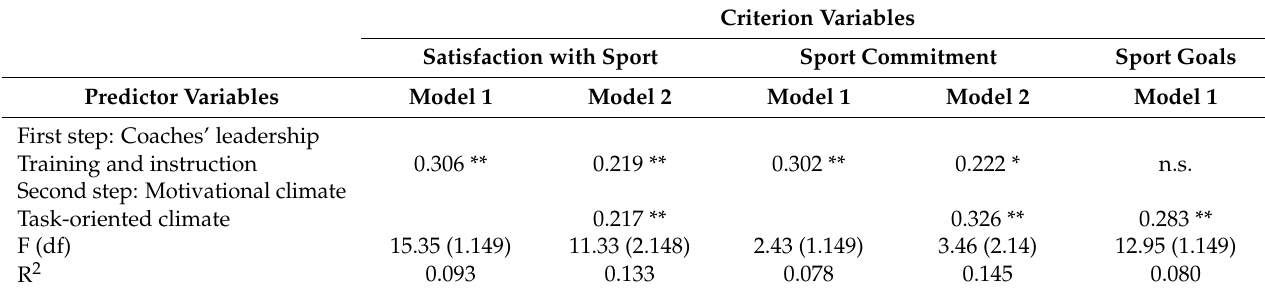
Table 2. Regression analyses for satisfaction with sport, sport commitment, and sport